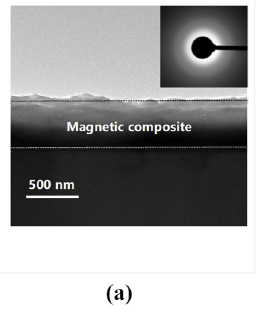
Figure 4. Soft magnetism of the magnetic composite: ( a ) the cross-section and diffraction pattern of (FeGaB (120 nm)/Al 2 O 3 (5 nm)) 4 /FeGaB (120 nm) by TEM and a comparison of the soft magnetism between ( b ) FeGaB and ( c ) (FeGaB (120 nm)/Al 2 O 3 (5 nm)) 4 /FeGaB (120 nm) through a magnetic hysteresis loop by VSM and surface roughness by AFM.